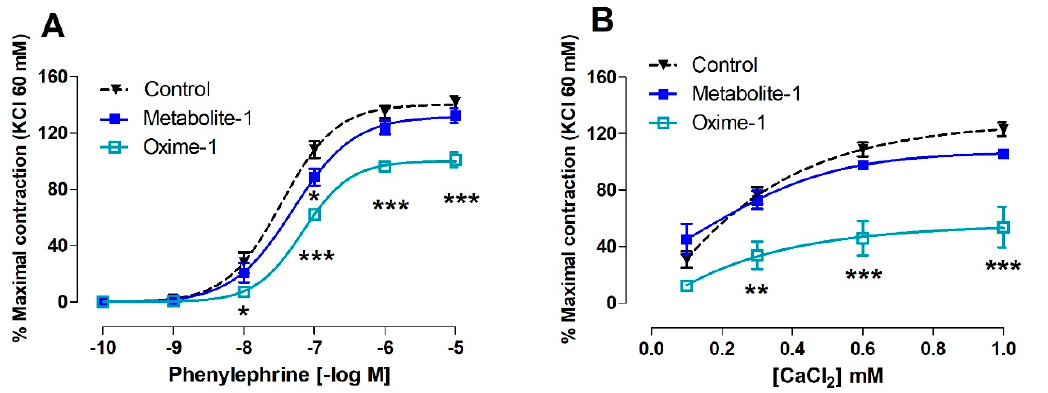
Figure 7. Effect of metabolite–1 and oxime–1 on the contractile response to PE in rat aorta. The contraction to PE was compared to contraction with KCl 60 mM obtained at the beginning of the experiment, during the equilibration period of tissues. Intact aortic rings were pre-incubated with 10 − 5 M metabolite or oxime for 20 min. Subsequently, aortic rings were contracted with cumulative concentrations of PE (10 − 10 to 10 − 5 M) ( A ). In addition, the aortic rings were pre-incubated in a Ca 2+ -free buffer for 10 min before 10 − 7 M PE was added, and then, the CaCl 2 (0.1 to 1 mM) was added to the bath ( B ). Data are presented as the average standard error of the mean (SEM) of 4 independent experiments. * p < 0.05; ** p < 0.01; *** p < 0.001 versus the curve in the absence of bioactive molecules (control).